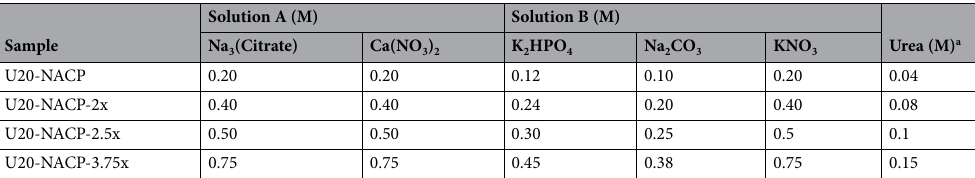
Table 2. Synthetic conditions for the materials prepared during the optimization of the amount of urea adsorbed in the NPs. In all cases, solution A contained Na 3 (Citrate) (0.20 M) and Ca(NO 3 ) 2 (0.20 M); solution B contained K 2 HPO 4 (0.12 M), Na 2 CO 3 (0.10 M) and KNO 3 (0.20 M). The concentration of urea is calculated as amount of urea added per total volume of the reaction. The total nitrogen content (wt%) from elemental analysis is provided for fully amorphous samples). a Concentration calculated as amount of urea added per total volume of the reaction.